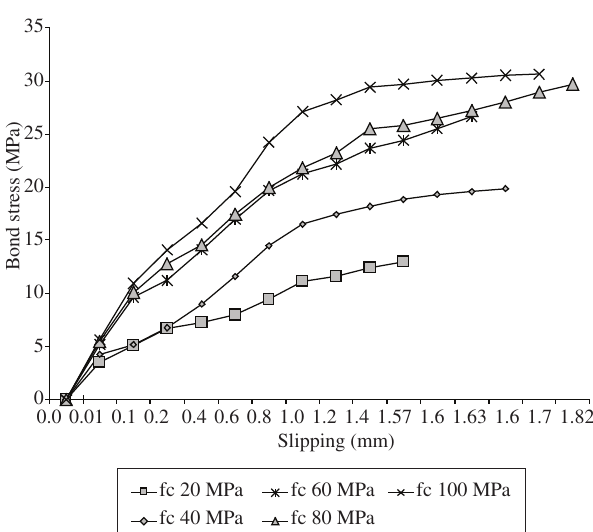
Figure 2. Bond Stress vs. Slipping ( f = 12.5 mm).